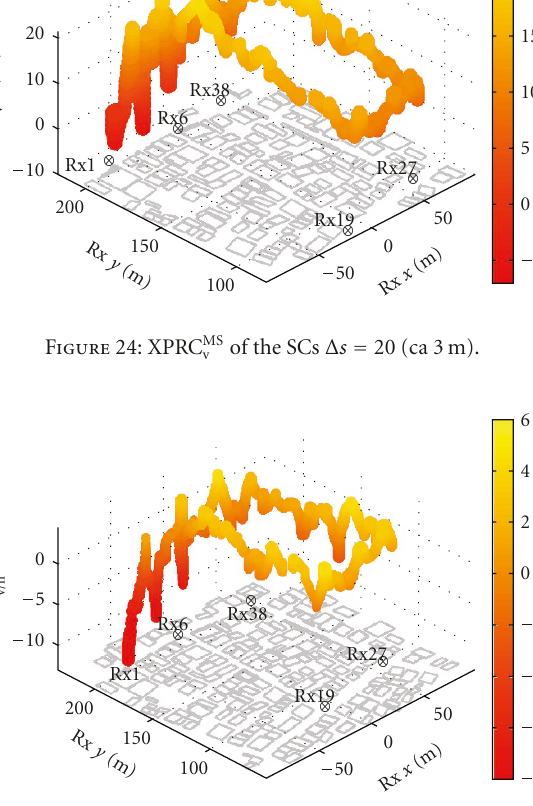
Figure 25: PC MS of the SCs Δ s = 20 (ca 3 m). v/h